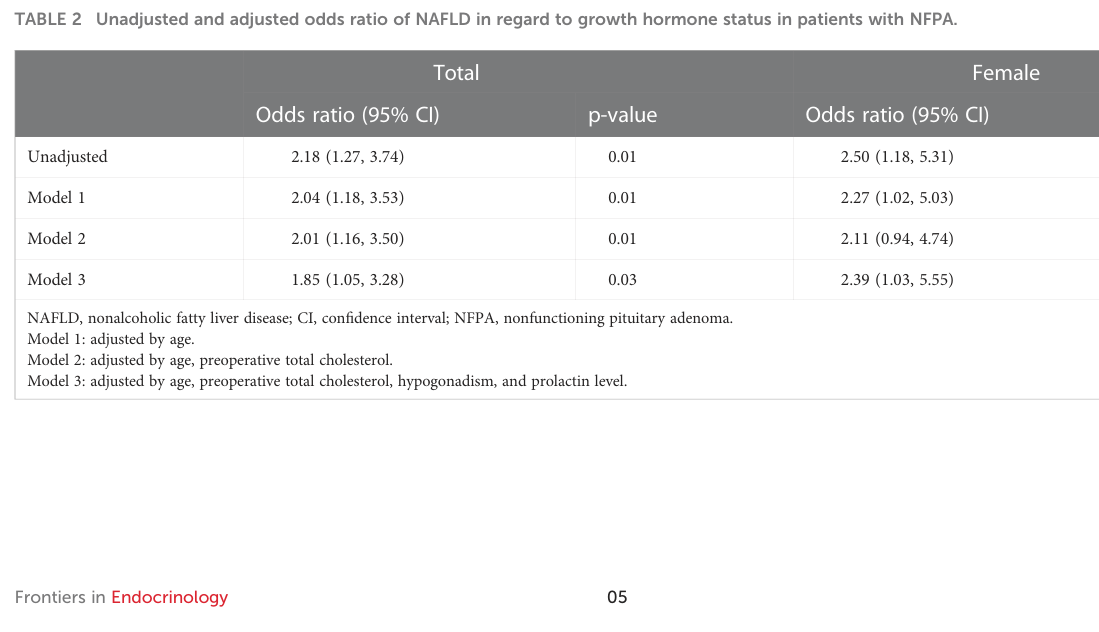
TABLE 2 Unadjusted and adjusted odds ratio of NAFLD in regard to growth hormone status in patients with NFPA. Total Female Odds ratio (95% CI) p-value Odds ratio (95% CI) p-value Unadjusted 2.18 (1.27, 3.74)